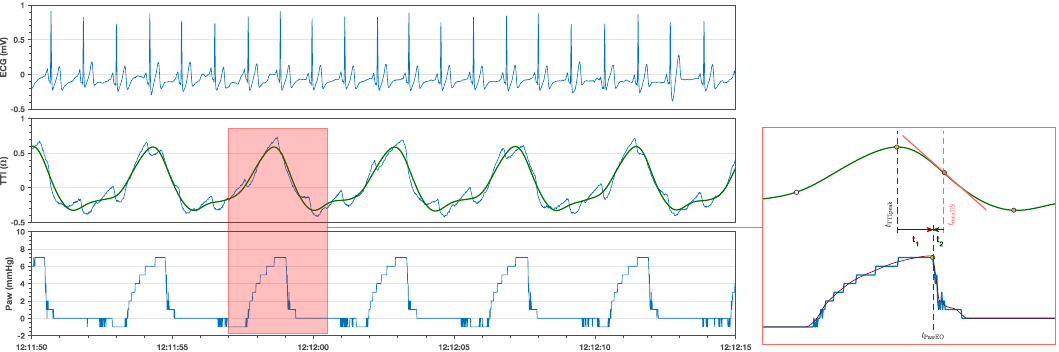
Figure 1. A 25s example of the data recorded by the LP15 with the electrocardiogram (ECG) (top channel), raw transthoracic impedance (TTI) (middle channel) and airway pressure (Paw) line (bottom channel). The raw impedance (blue) shows a strong circulation component aligned with the QRS complexes in the ECG. This component was filtered to obtain the ventilatory component in green. The red square highlights a typical ventilation waveform and the fiducial points in the TTI. As reference an interpolated Paw curve (in red) is superposed to the Paw curve (blue) to show how Paw gradually approaches the Paw EO point. The time intervals t 1 = t PawEO − t TTIpeak and t 2 = t PawEO − t maxDS are the ones used in Figures